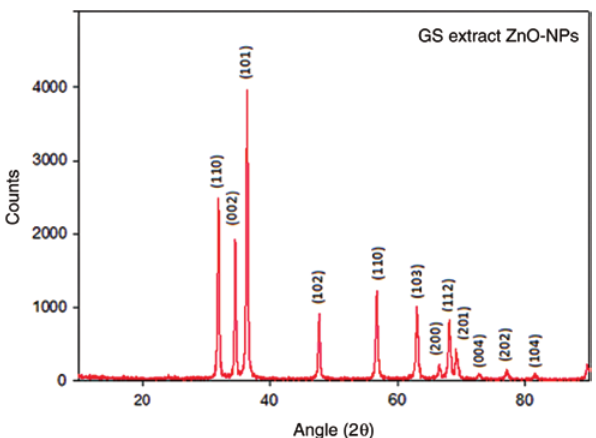
Figure 3: X-ray diffraction (XRD) patterns of GS zinc oxide nanopar- ticles (ZnO-NPs)